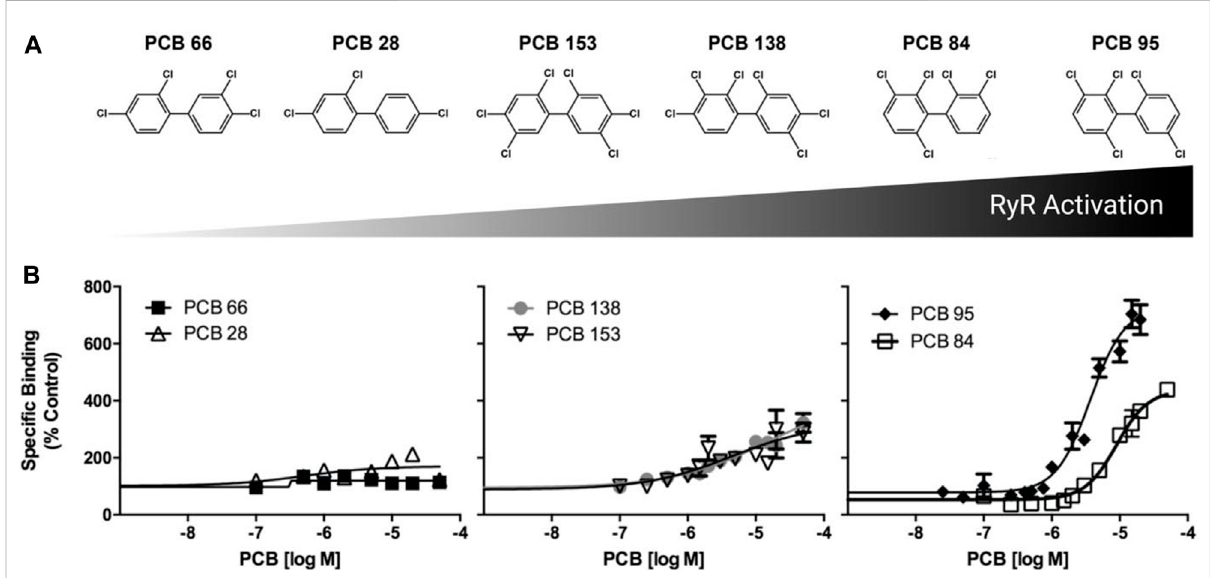
FIGURE 1 PCB induced [3H]-labeled ryanodine activation and binding in adult zebra fi sh skeletal muscle. (A) Depiction of congener structure and relative RYR activation. (B) [ 3 H]-ryanodine (Ry) binding was measured in the presence of speci fi c PCB congeners at 0.1 – 50 µM. Speci fi c binding shown as a percentage of the DMSO control. Data presented as mean ± SEM from six adult (~1 year old) zebra fi sh.